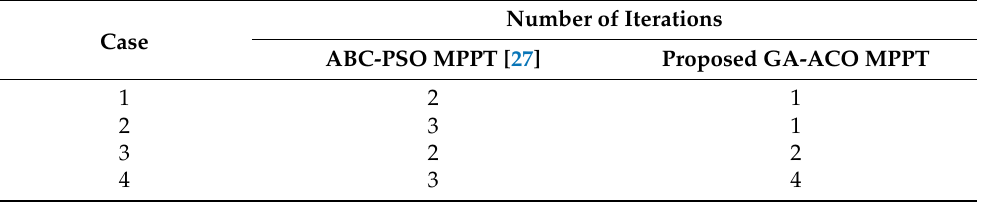
Table 4. The hybrid MPPT comparison.